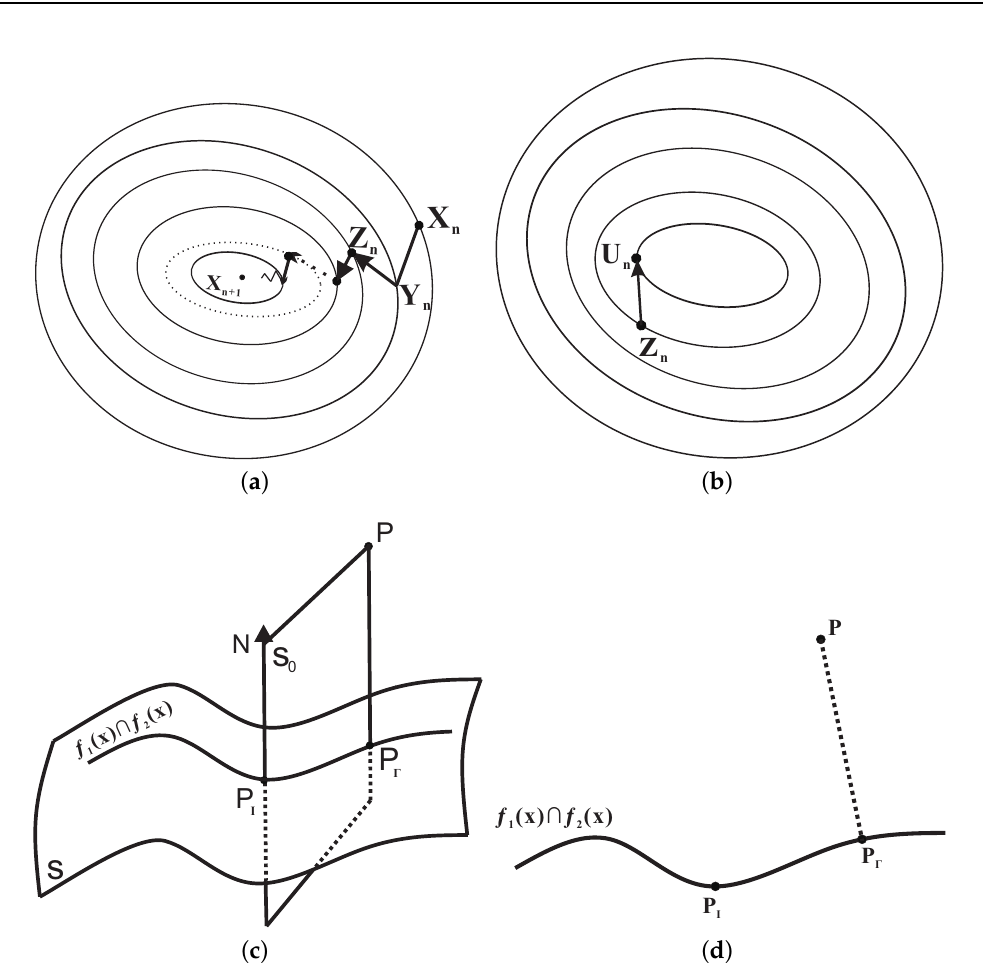
Figure 4. Graphic interpretation of the whole iteration process in Algorithm 3. ( a ) Newton’s steepest gradient descent method in the first step and in the second step; ( b ) The Newton’s iteration method related to the test point in the third step; ( c ) Correcting the previous iteration point to improve the robustness and high efficiency of iteration in the last step; ( d ) The iterative point P I finally iterates to the orthogonal projection point P Γ